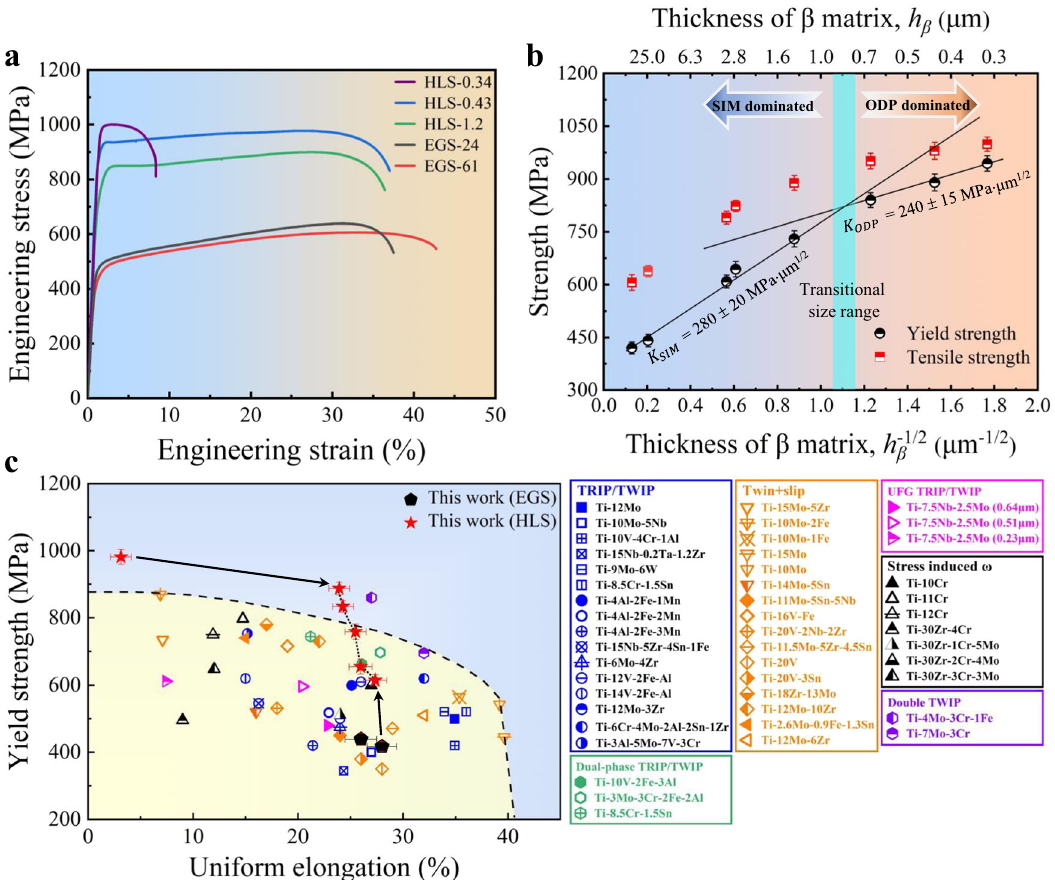
Fig. 3 | The mechanical responses of β -Ti alloys. a The engineering stress – strain Ti-8.5Cr-1.2Sn; 14 Twin+slip Ti alloys: Ti-3Al-5Mo-7V-3Cr 35 , (Ti-15Mo-5Zr, Ti-10Mo- curves. b The yield/tensile strength of the present β -Ti alloys with different β -layer 2Fe,Ti-10Mo-1FeandTi-15Mo) 36 ,Ti-10Mo,(Ti-14Mo-5SnandTi-11Mo-5Sn-5Nb) 43 ,Ti- 16V-1Fe 44 , Ti-20V-2Nb-2Zr 45 , (Ti-11.5Mo-5Zr-4.5Sn, Ti-20V-3Sn and Ti-20V) 46 , Ti-6Cr- thicknesses. The predicted critical stress for the activation of SIM and ODP is 4Mo-2Al-2Sn-1Zr 47 , Ti-18Zr-13Mo 48 , (Ti-12Mo-10Zr and Ti-12Mo-6Zr) 50 , Ti-2.6Mo- associated with different H – P slopes, i.e., K SIM =280±20MPa μ m 1/2 for SIM and μ m 1/2 for ODP, revealing a critical size of ~0.80±0.07 μ m for K 0.9Fe-1.3Sn; 49 UFG TRIP/TWIP Ti alloys: Ti-7.5Nb-2.5Mo (with different β grain ODP =240±15MPa the SIM to ODPtransition. c A comparison ofyieldstrength vs . uniform elongation sizes); 41 Stress-induced ω Tialloys:(Ti-10Cr,Ti-11Cr,andTi-12Cr) 64 ,(Ti-30Zr-4Cr,Ti- 30Zr-1Cr-5Mo,Ti-30Zr-2Cr-4Moand Ti-30Zr-3Cr-3Mo); 40 DoubleTWIPTialloys:Ti- of our β -Ti alloys with reported metastable β -Ti alloys, including TRIP/TWIP Ti 7Mo-3Cr 52 and Ti-4Mo-3Cr-1Fe 53 alloys. Error bars indicate standard deviations for alloys: Ti-12Mo 9,54 , Ti-10Mo-5Nb 43 , Ti-10V-4Cr-1Al 10 , Ti-15Nb-0.2Ta-1.2Zr 20 , Ti-9Mo- 6W 26 , Ti-8.5Cr-1.5Sn 37 , (Ti-4Al-2Fe-1Mn, Ti-4Al-2Fe-2Mn and Ti-4Al-2Fe-3Mn) 38 , Ti- three tests. More details (alloy composition and corresponding references) can be 15Nb-5Zr-4Sn-1Fe 39 , Ti-6Mo-4Zr 51 , (Ti-12V-2Fe-1Al and Ti-14V-2Fe-1Al) 44 , and Ti- found in Supplementary Table 12Mo-3Zr; 50 Dual-phaseTRIP/TWIPTialloys:Ti-10V-2Fe-3Al 13 ,Ti-3Mo-3Cr-2Fe-2Al 42 ,